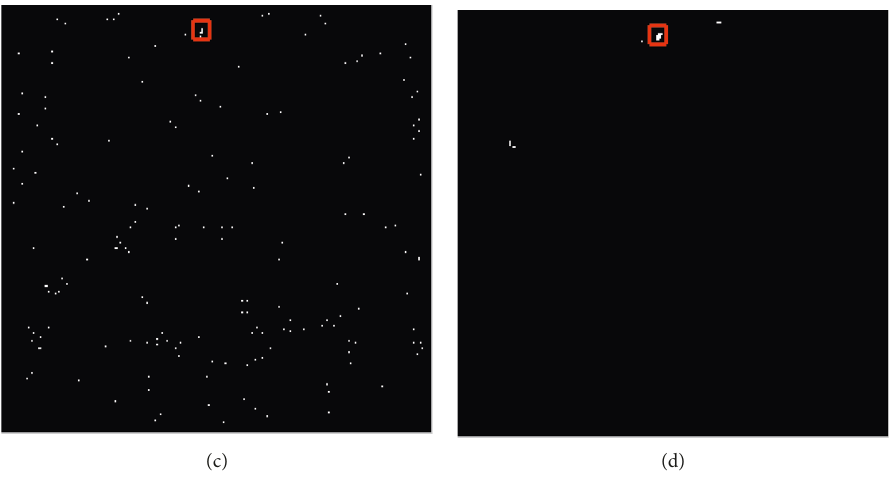
Figure 4: Segmentation results of different algorithms in scene 2.